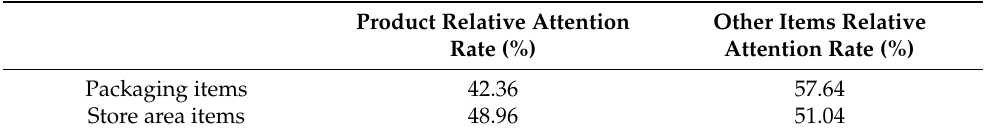
Table 6. Attention percentage of the total number of participants to the product, relative to other elements, for both packaging and store area. Source: Prepared by the